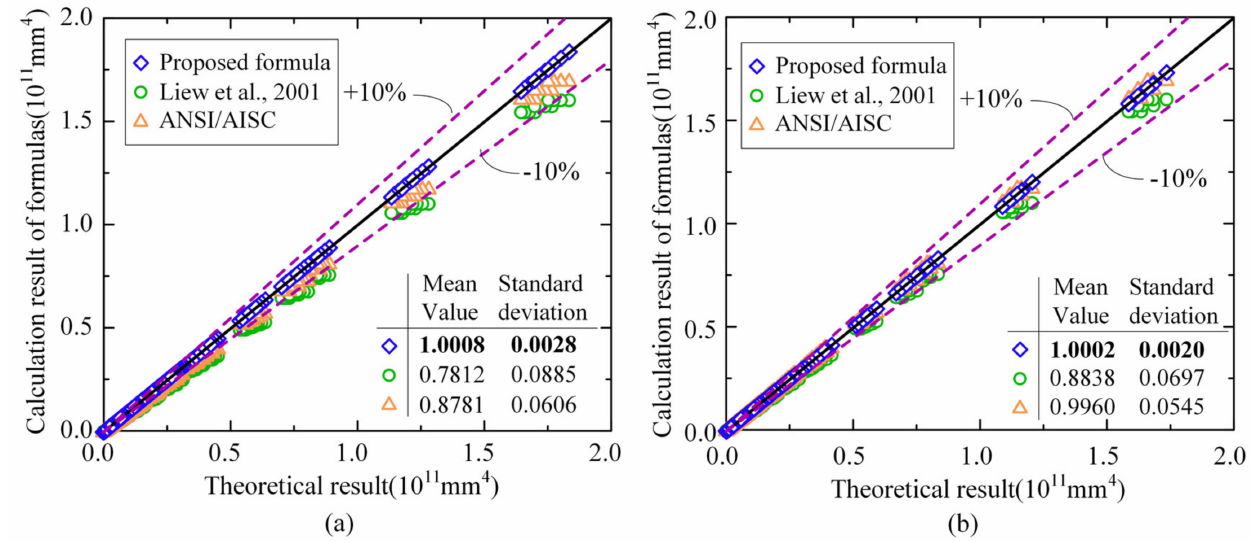
Figure 9. Comparison of the equivalent flexural stiffness calculated by the formula proposed in this paper and other existing methods. (( a ) Comparison of EI eq calculation results in large-span heavy-loading design conditions; ( b ) Comparison of EI eq calculation results in commonly arranged frame design